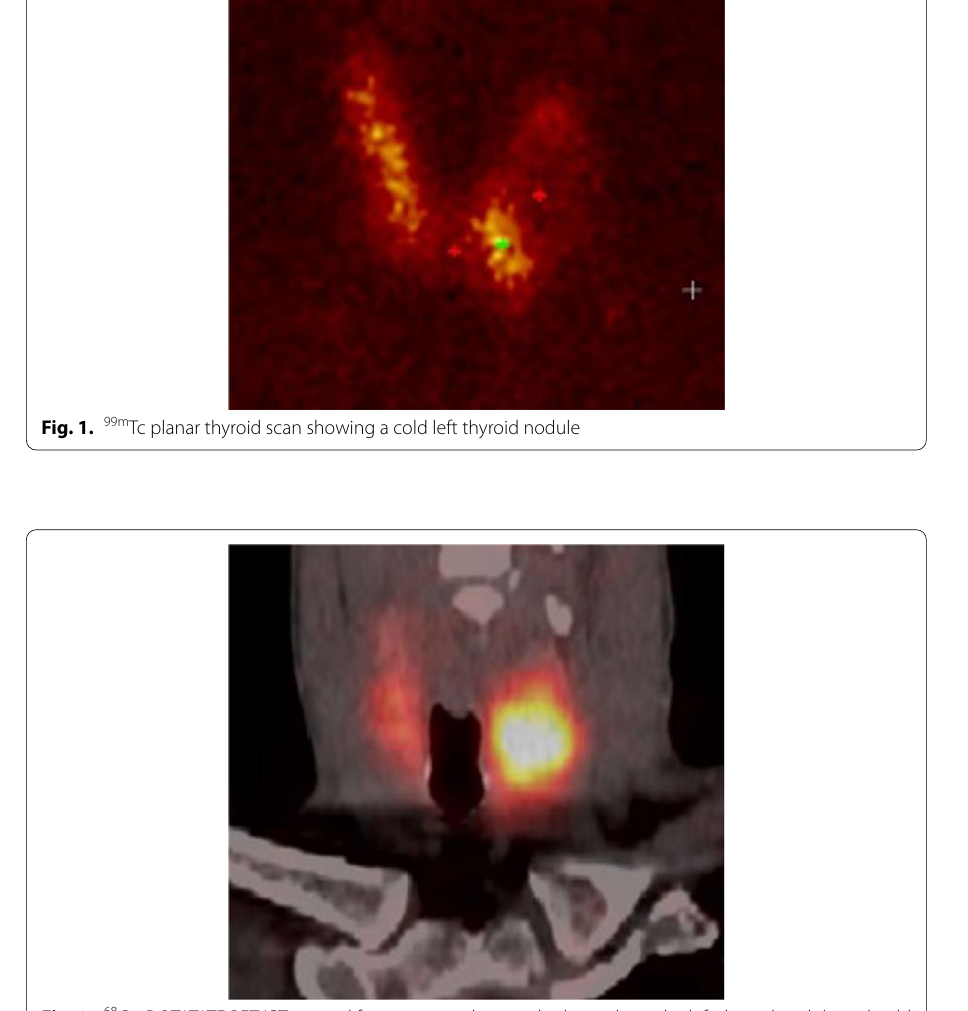
function tests were within the normal range as were serum levels of parathormone (PTH), Chromogranin A (CgA), carcinoembryonic antigen (CEA) and calcitonin. Ultrasonographic neck imaging showed bilateral intermediate-risk EU-TIRADS 4 thyroid nodules. The largest nodule, measuring 23 26 35 mm, was located in the × × left lobe. Thyroid scintigraphy using technetium-99 m pertechnetate showed a cold nodule located in the left lobe (Fig. 1). Fine-needle aspiration biopsy (FNAB) of the nodule did not demonstrate cellular atypia (Bethesda category II). For unknown rea- sons, 111 In-DTPA-octreotide scintigraphy was requested by the treating physician and displayed a high focal uptake in the left nodule. The same findings were observed on the 68 Ga-DOTATATE PET/CT, with a SUV max of 13.8 (Fig. 2). No other sites of pathological uptake were detected. The patient was discussed at the multidisciplinary